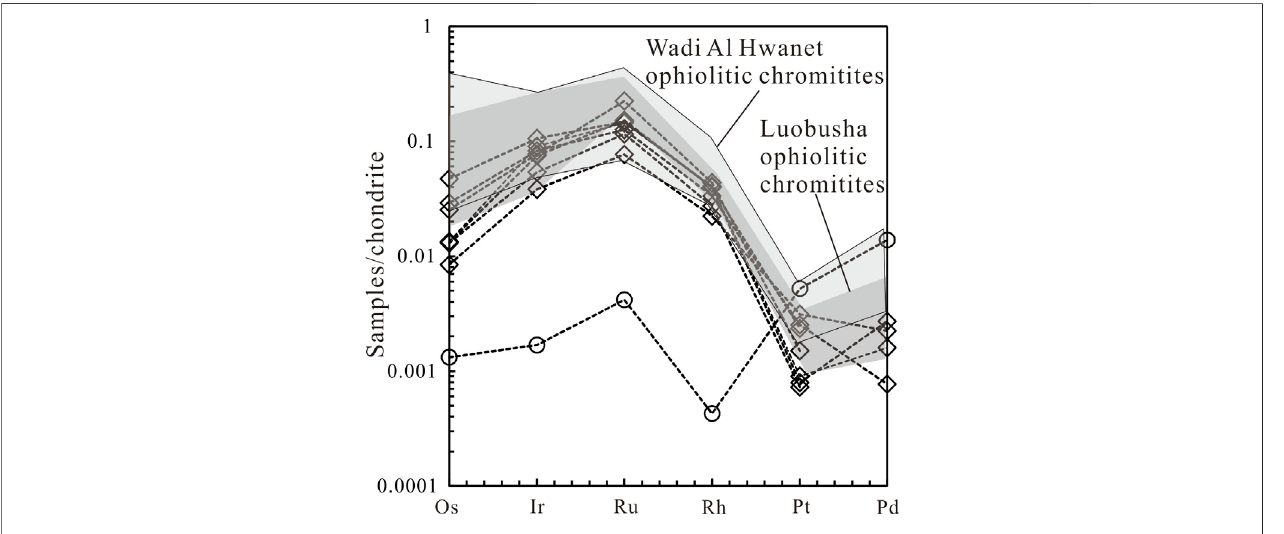
FIGURE 12 | Chondrite-normalized PGE patterns of the chromitites of the Hongshishan complex. The Luobusa ophiolitic chromitite fi elds (Zhou et al., 1996) and Wadi Al Hwanet ophiolitic chromitites are used for comparison. Normalizing values currently in use are after Naldrett and Duke (1980; cf. 514, 540, 690, 200, 1,020 and 545 for Os, Ir, Ru, Rh, Pt, and Pd, respectively).